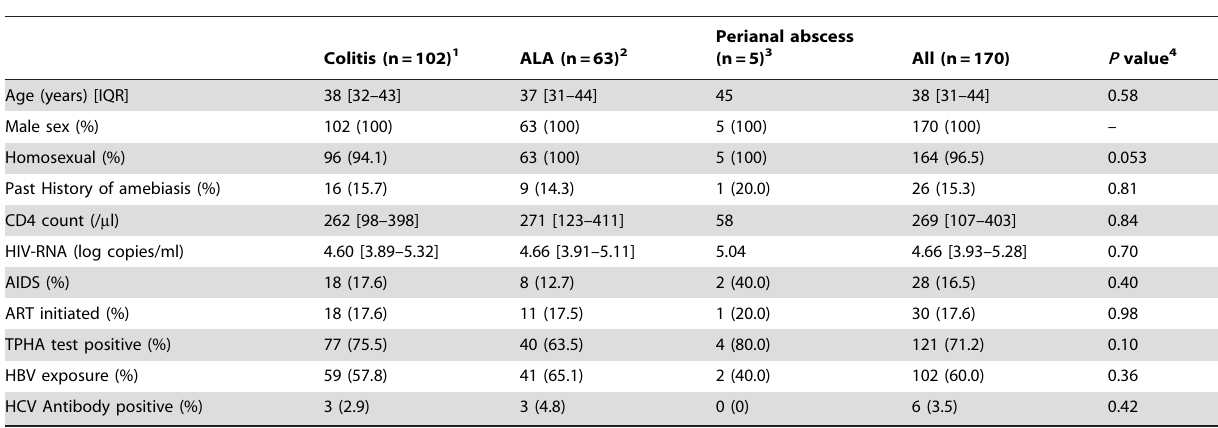
Table 1. Patient demographics, state of HIV, and serological markers.